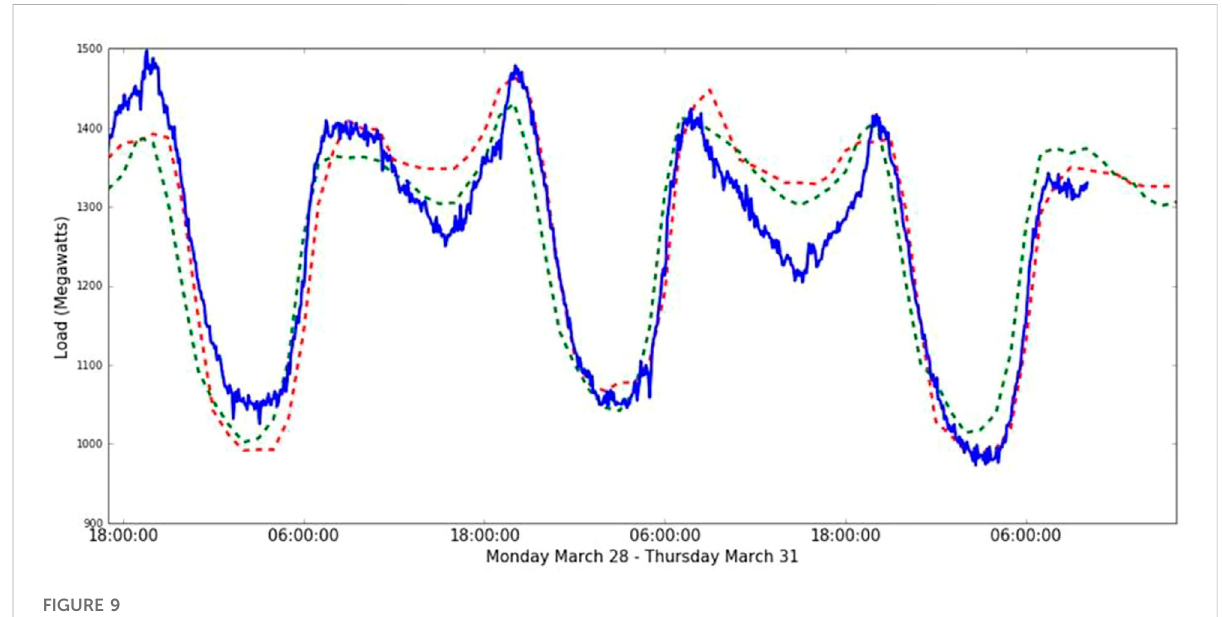
FIGURE 9 The forecasted EEC at the end of March 2016.